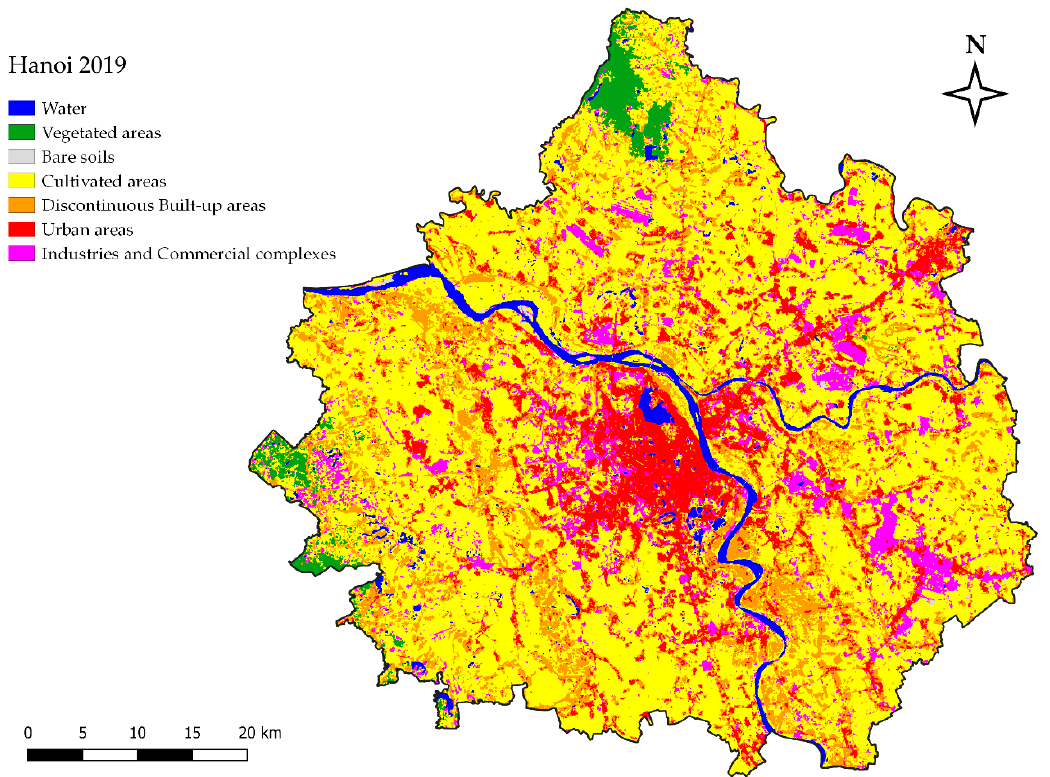
Figure 9. The 2019 land cover map of the study area.